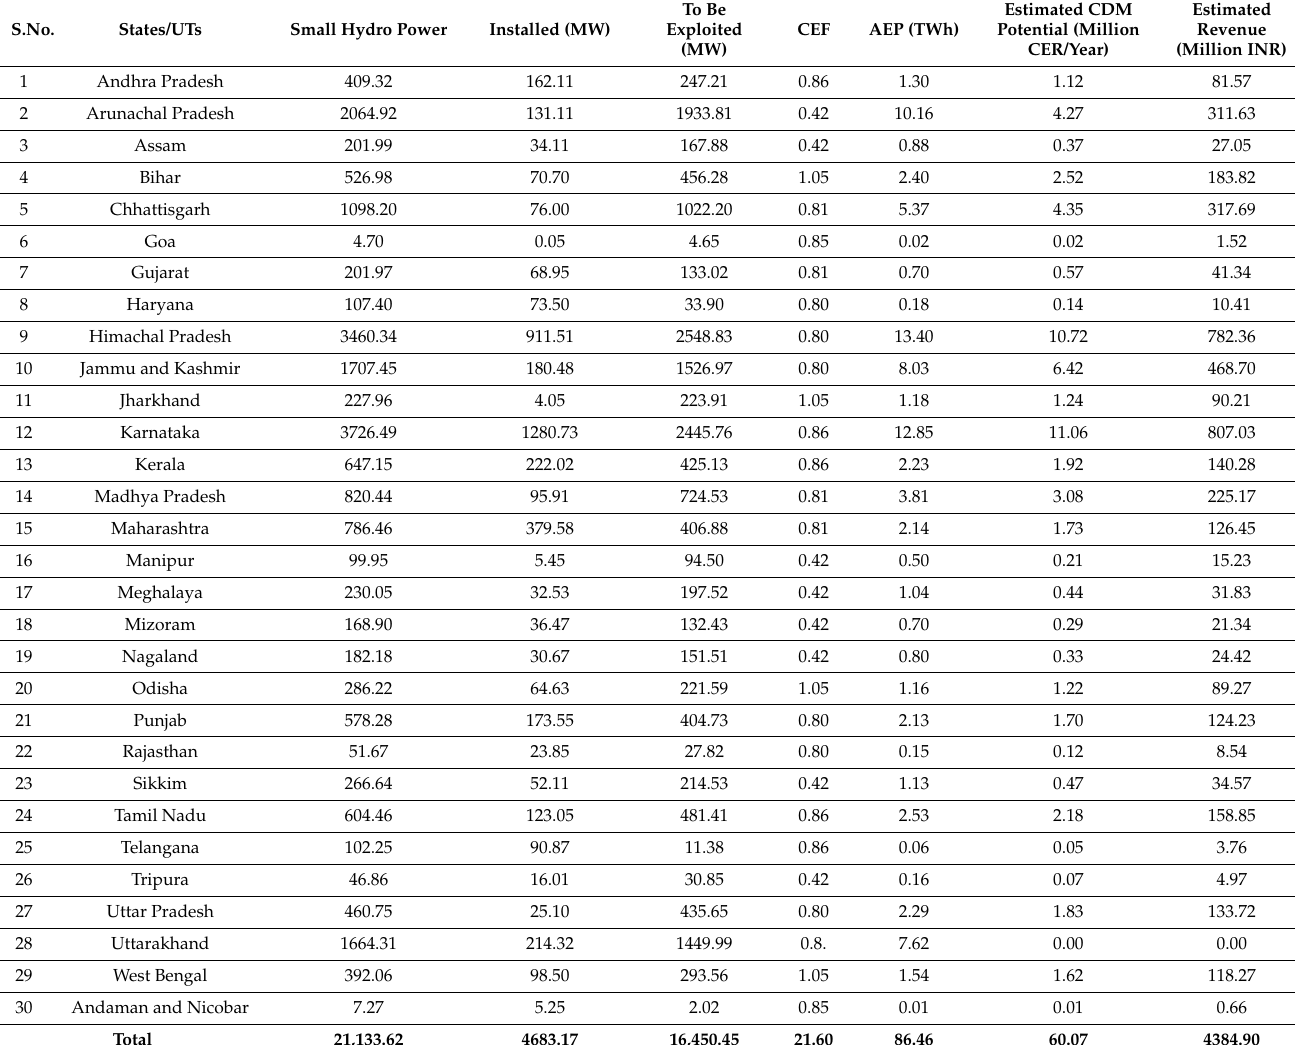
Table 2. CDM potential of SHP projects in